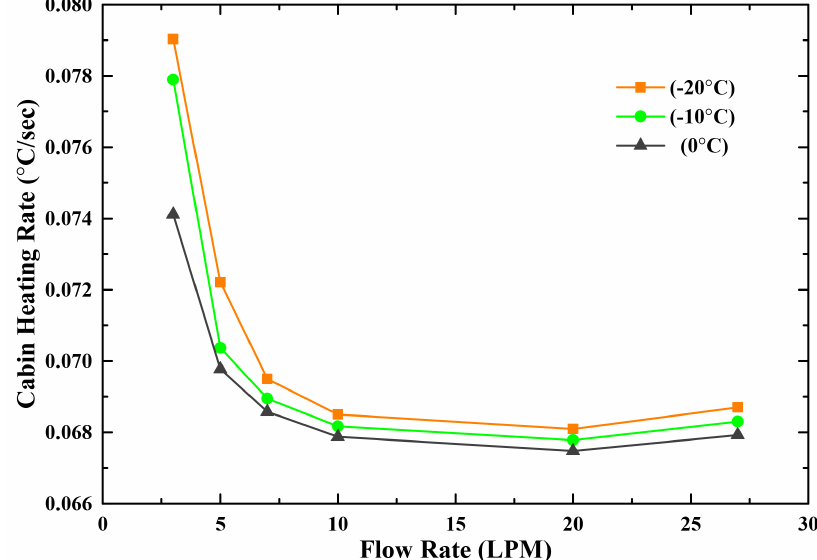
Figure 13. Cabin heating rate versus flow rate at 400 CMH airflow and heater capacity: 6 kW.